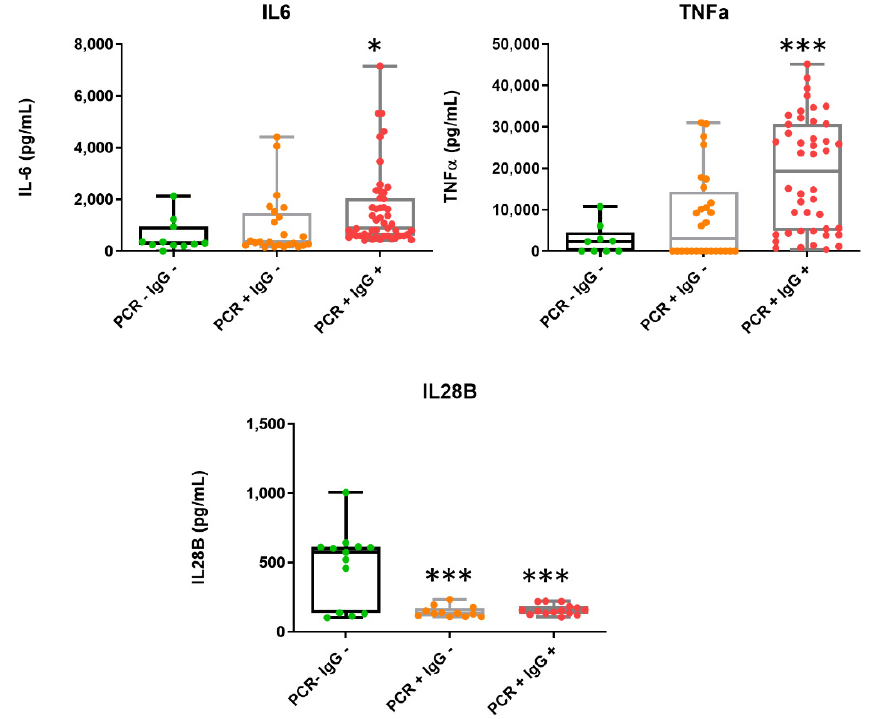
Figure 1. Determination of cytokine concentrations in patient samples. Box-and -whisker plots of IL-6, TNF- α and IL-28B levels in the serum of patients. PCR − IgG − , patients with a discharge diagnosis of COVID-19 (green); PCR+ IgG − , patients with early SARS-CoV-2 infection (orange); PCR+ IgG+ patients with active SARS-CoV-2 infection (red). Data represent the mean ± S.D. * p ≤ 0.05; *** p ≤ 0.001.